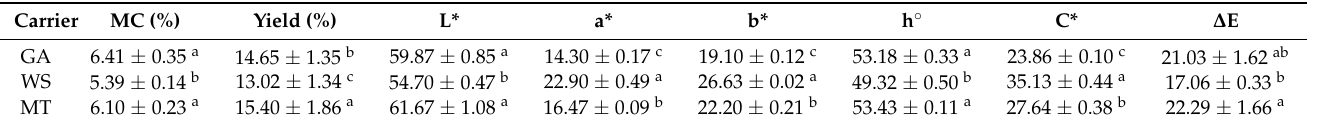
Table 1. Moisture content (MC), yield (%) and color of freeze-dried passion fruit peel powders obtained with GA, WS, and MT as